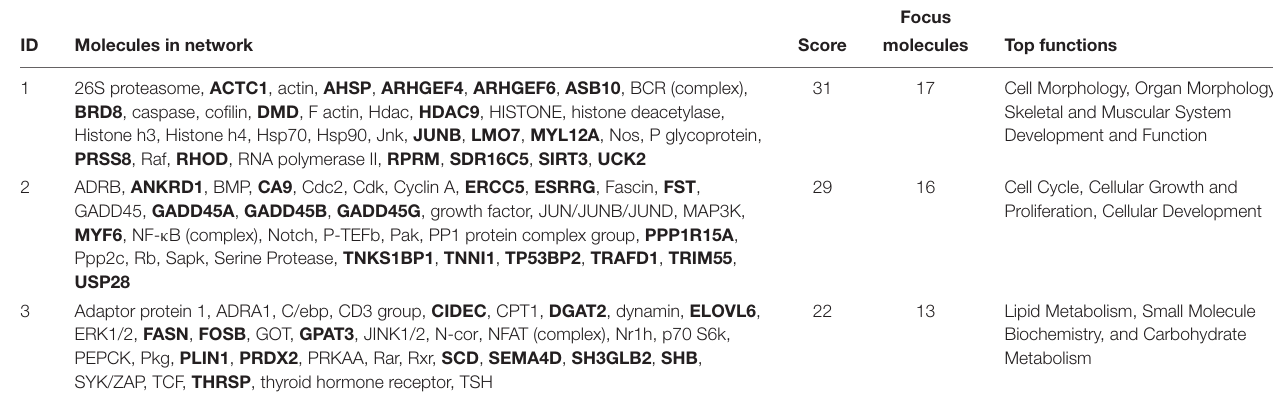
TABLE 4 | Top three networks enriched with DE genes detected by IPA software.